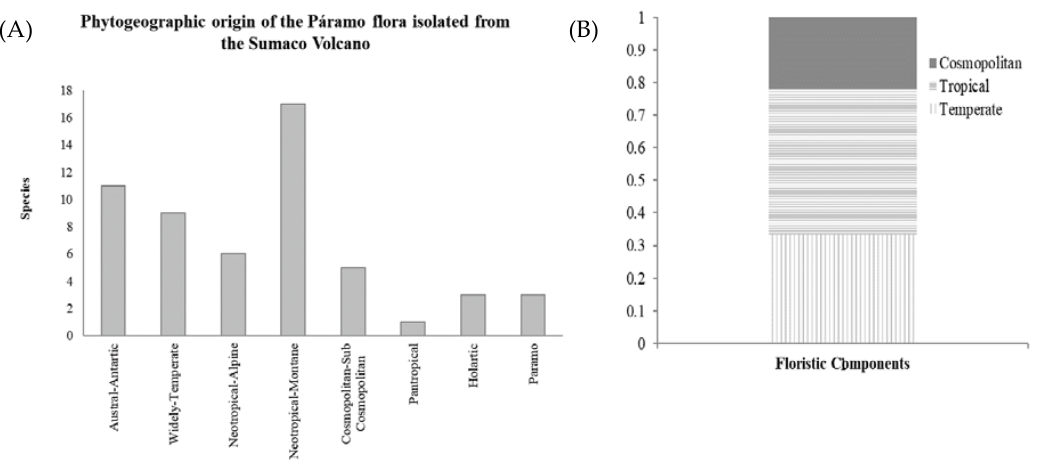
Figure 6. Geographical Distribution of Vascular Flora of Sumaco Paramo. ( A ) Species versus phytogeographic origin of the Paramo flora isolated from the Sumaco volcano; ( B ) Floristic components in relative distribution.